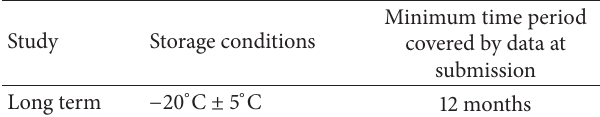
Table 3: Conditions for active ingredients stored in freezers